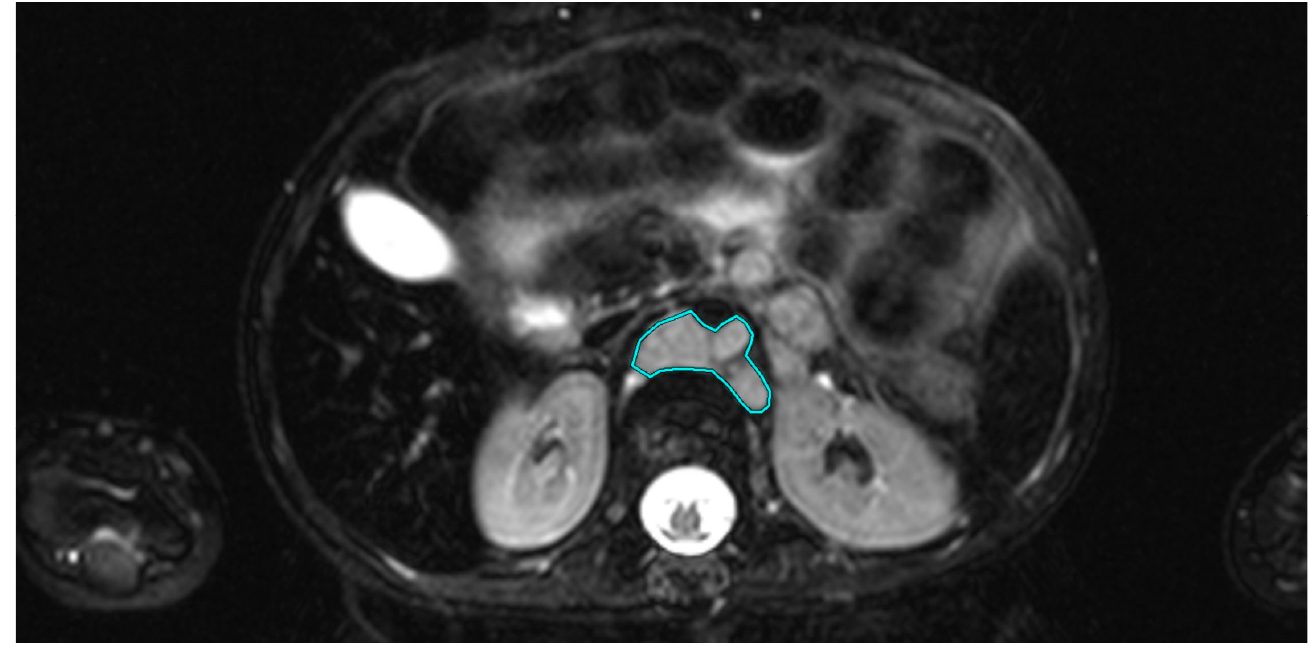
Figure 1. Axial T1-weighted image of a 2-year-old patient with stage IV neuroblastoma. The tumor is located para-aortally. The region of interest (ROI) is shown in turquoise, drawn using the “closed polygon” tool.